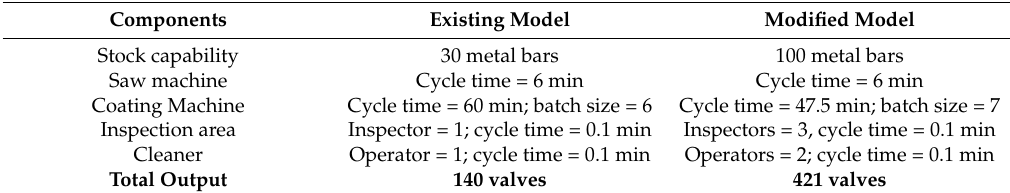
Table 3. Changes based on the budget.